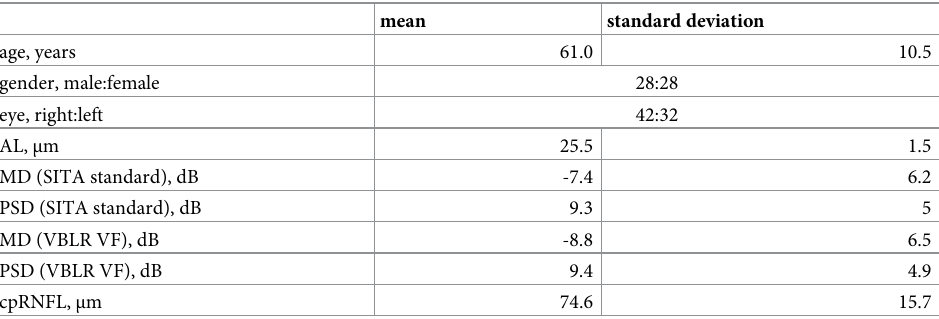
Swedish interactive thresholding algorithm; VBLR, variational Bayes linear regression; VF, visual